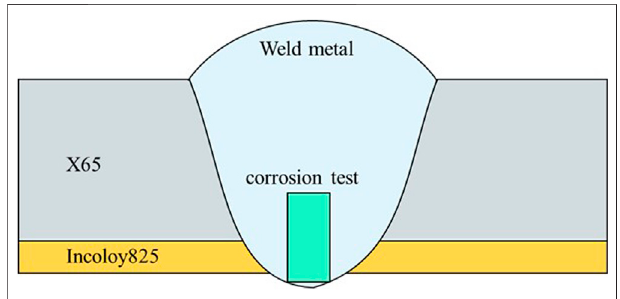
FIGURE 1 | Sampling diagram of the corrosion